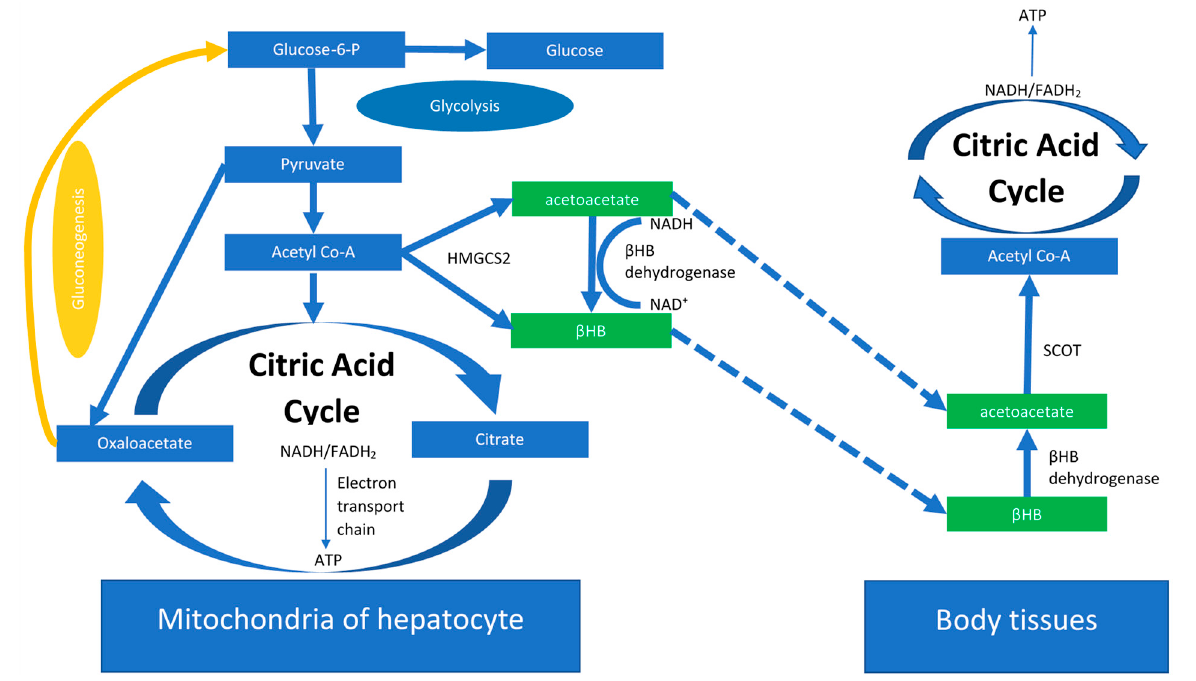
Figure 1. Ketogenesis is initiated upon deficiency in glucose intake. Ketone bodies are produced as a result which from mitochondria of hepatocytes which can later be used by other body tissues as a form of energy. ATP: adenosine triphosphate, β HB: β -hydroxybutyrate, HMGCS2: 3-hydroxy-3- methylglutaryl-CoA synthase 2, Glucose-6-P: Glucose-6-phosphate, NADH: nicotinamide adenine dinucleotide hydrogen, FADH 2 : D flavin adenine dinucleotide, SCOT: succinyl-CoA:3-ketoacid CoA transferase